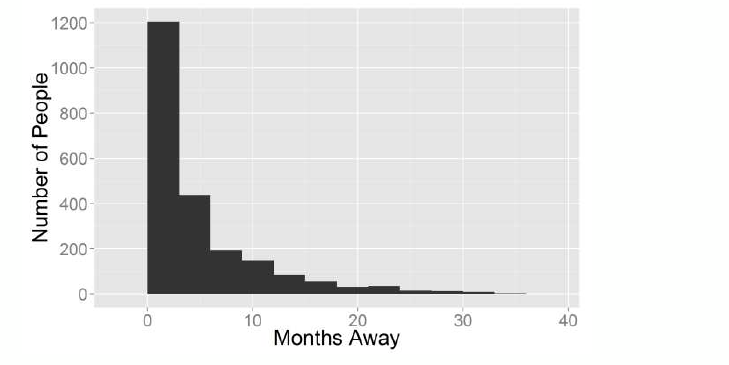
Figure A1.6: Empirically derived histogram of individual out-migration times (time from out- migration until return to Chitwan) in the Chitwan